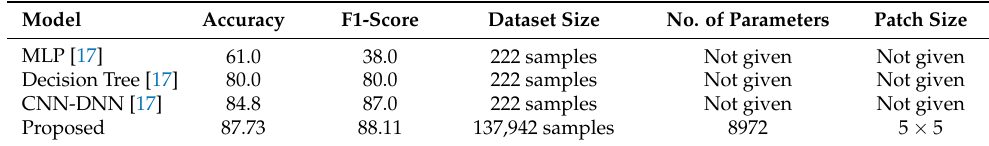
Table 2. Comparison with state-of-the-art approaches. This table is included as a qualitative type comparison since the compared methods have been designed and trained under data sets with a significant difference in both the source and size of the